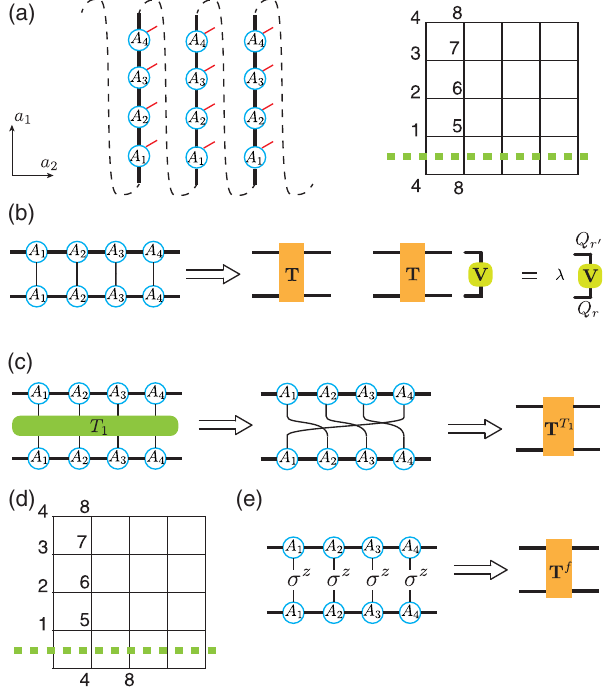
FIG. 6. The graphical representation of (a) the MPS and (b) the transfer matrix. The quantum number of the eigenvalue is determined by q ¼ Q r − Q r 0 . (c) The mixed transfer matrix to calculate the momentum k 1 of each Schmidt basis. (d) The − 1 geometry for the square lattice (it is analogous to the − 2 geometry for the kagome lattice). The periodic condition is found by identifying the sites labeled by the same number. (e) The mixed transfer matrix for the fermionic